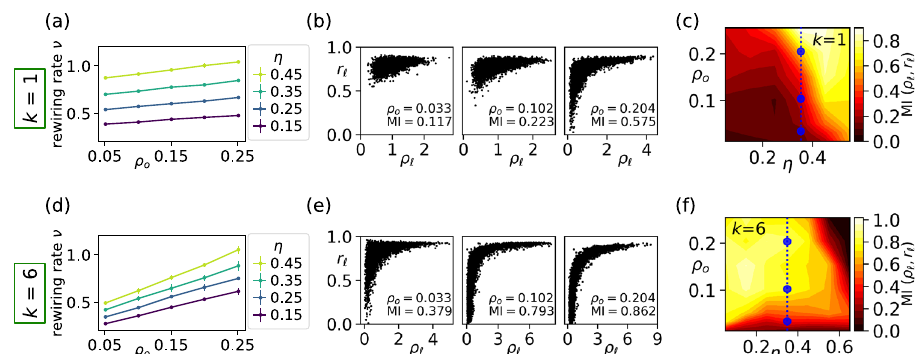
Fig. 7 Quantifying rewiring and the (local) density-order coupling in the k -nearest neighbor interaction ( k NN). The number of neighbors is k = 1 ( a – c ) and k = 6 ( d – f ). a , d The rewiring rate ν as a function of obstacle density ρ o for different values of dynamical noise. Error bars represent the standard deviation of rewiring over different realizations of the obstacle fi eld. Note that error bars are often comparable or smaller than the symbol size. b , e Local order r ℓ versus local particle density ρ ℓ for different obstacle densities ρ o (see “ Methods ” for details); the corresponding value of mutual information MI( ρ ℓ , r ℓ ) is also reported. c , f Mutual information MI( ρ ℓ , r ℓ ) versus dynamical noise and obstacle density. The dashed lines indicate the dynamical noise strength η = 0.35 used in ( b , e ), with points indicating the corresponding obstacle densities.